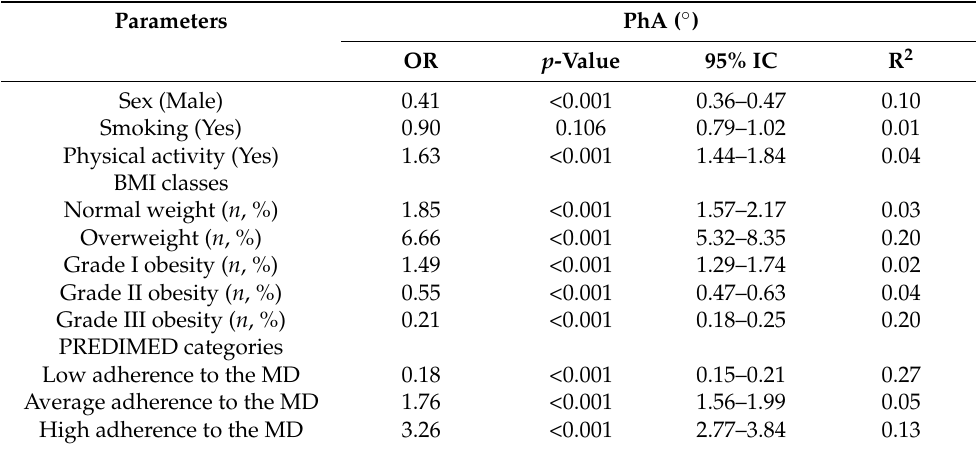
Table 4. Bivariate proportional odds ratio model to assess the association between PhA and categori- cal variables included in this study.